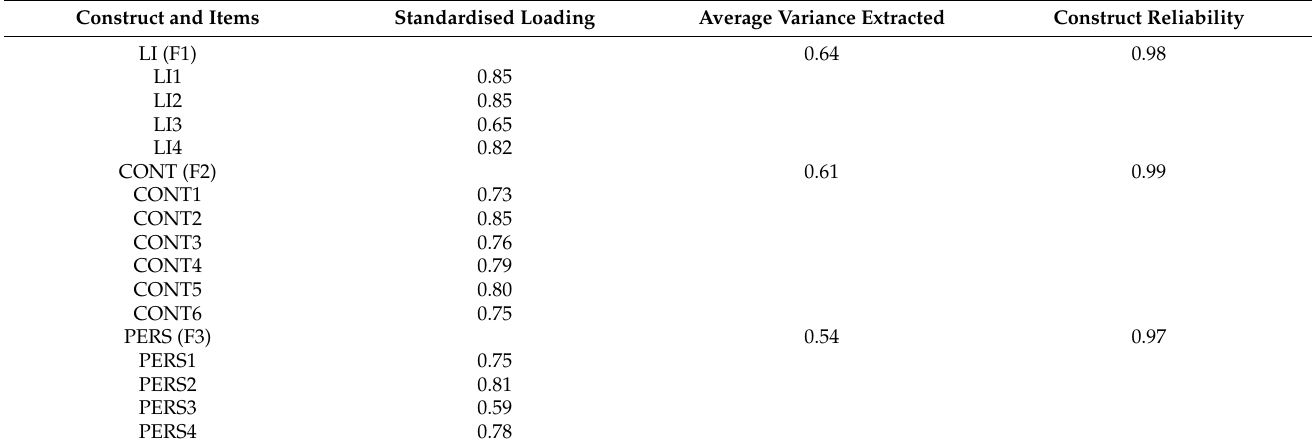
Table 4. Standardised loadings, average variance extracted, and construct reliability coefficients of the three-factor first-order